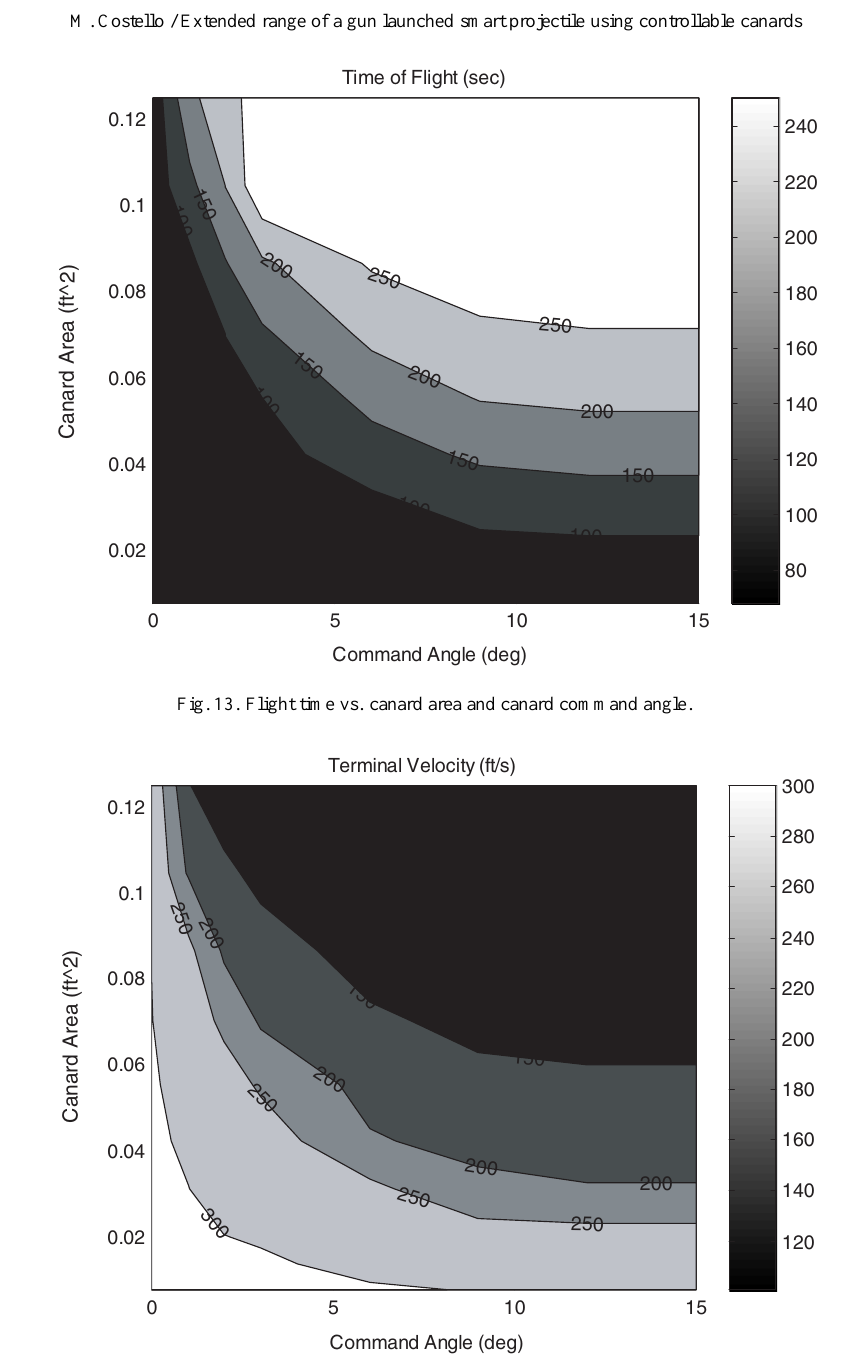
Fig. 14. Terminal velocity vs. canard area and canard command